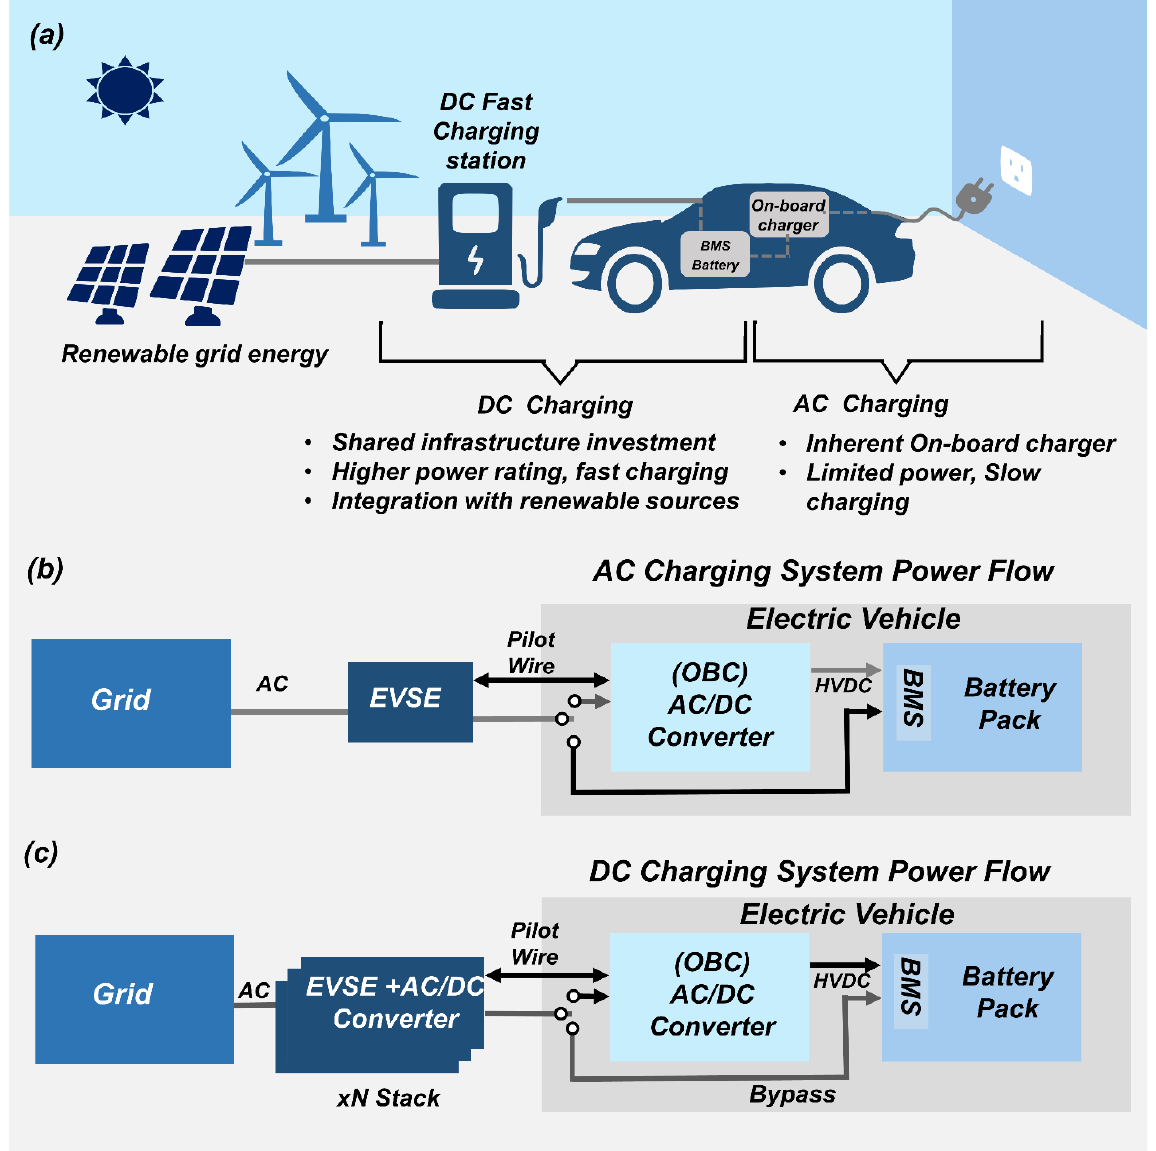
Figure 7. Conceptual diagram of V2G enabled charging system: ( a ) Differences between AC, DC charging and on-board charger ( b ) Level 1 and Level 2 AC charging stations and ( c ) Level 3 DC charging station (fast charging) (redrawn from [44].)